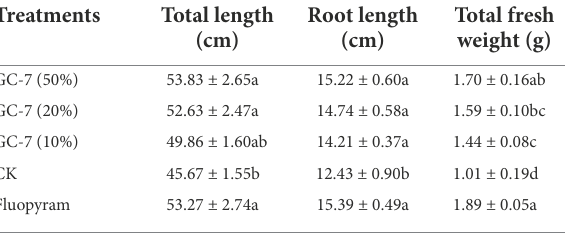
TABLE 2 Effects of biocontrol agents (isolate GC-7) on the growth parameters of rice plants infected with Meloidogyne graminicola in pot-based experiments.